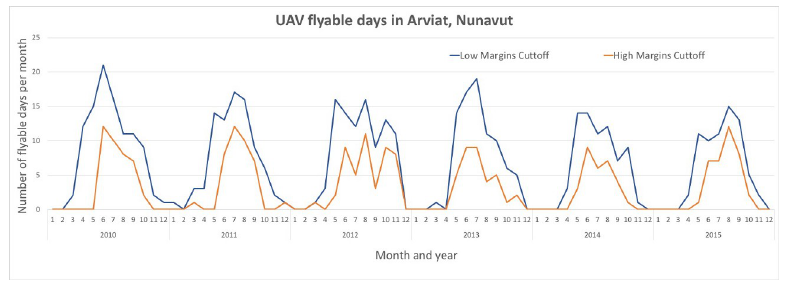
Fig 7. UAV weather constraints. Five years of daily weather observations were assessed for suitability of UAV flight. This graph depicts the number of days (under model 1 and 2) that were deemed suitable for UAV flights.